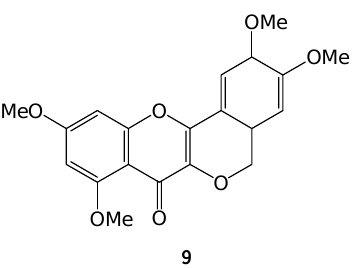
Figure 2. Structure of β